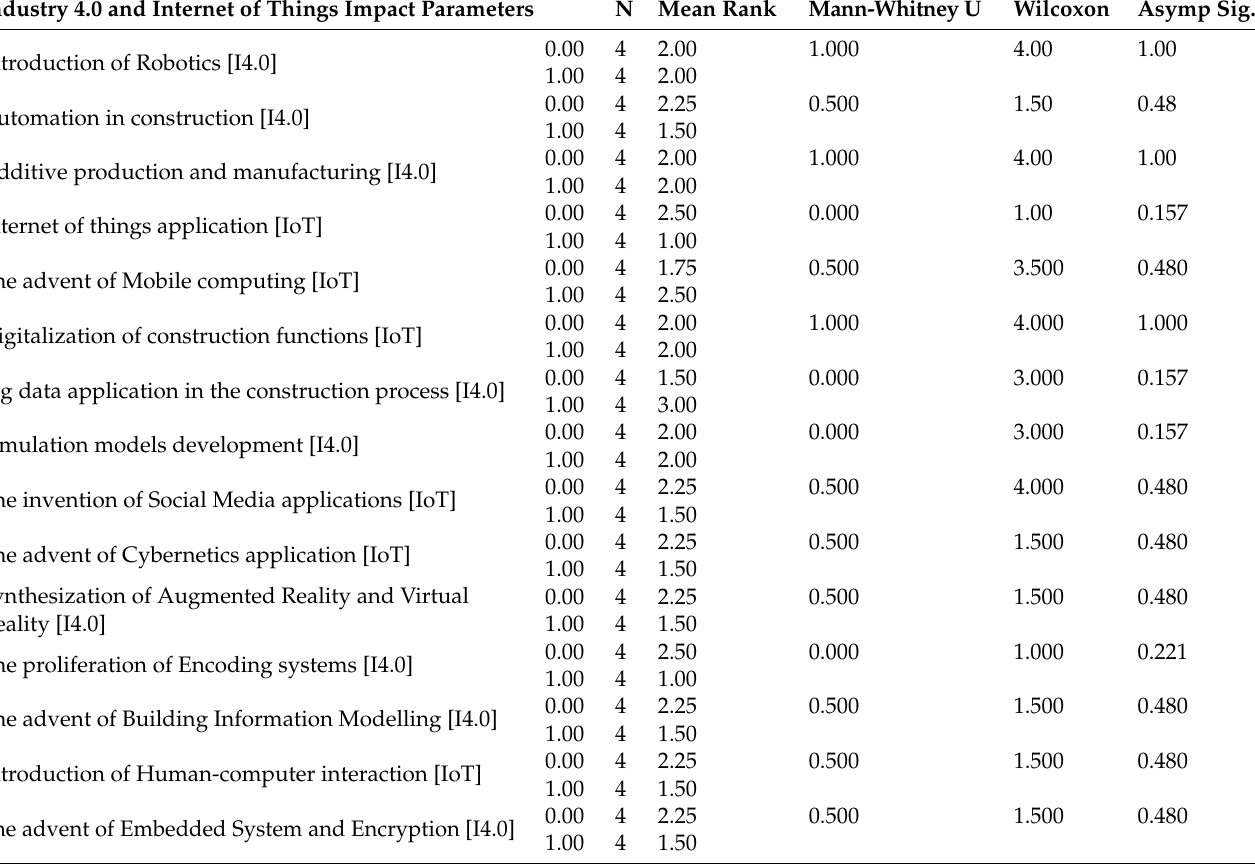
Table 6. Mann–Whitney U and Wilcoxon W statistical test results on Internet of Things (IoT) and Industry 4.0 impacts on quality management process of a construction project.